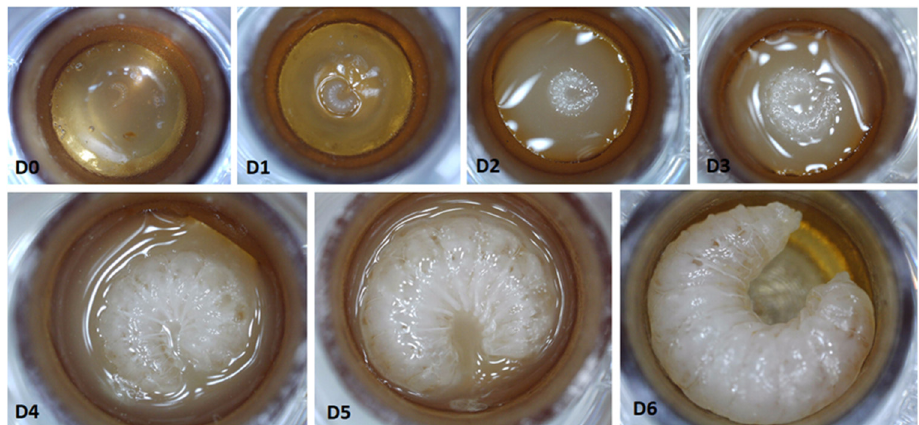
Figure 1. Development of a larva from day of translation ( D0 ), and one day ( D1 ), two days ( D2 ), three days ( D3 ), four days ( D4 ), five days ( D5 ), and six days ( D6 ) after translation. The larva on day six fully consumed the food, completing the feeding process. The photos (except D1 and D6 when the larvae were not fed) were taken after the scheduled feeding.